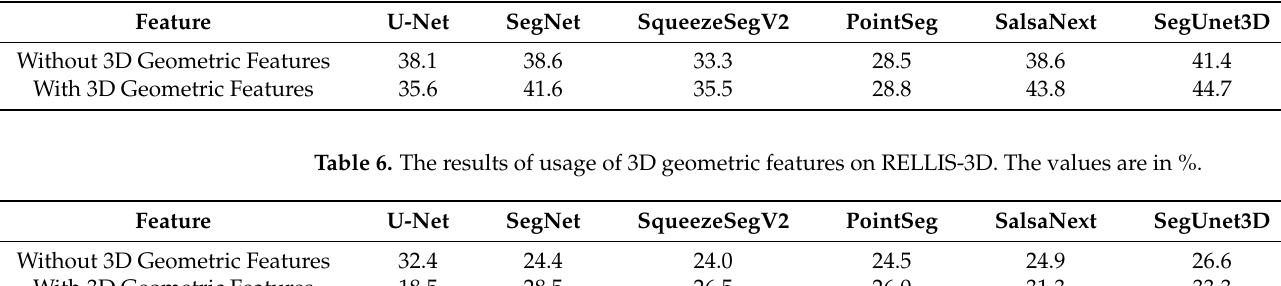
Table 5. The results of usage of 3D geometric features on SemanticPOSS. The values are in %.